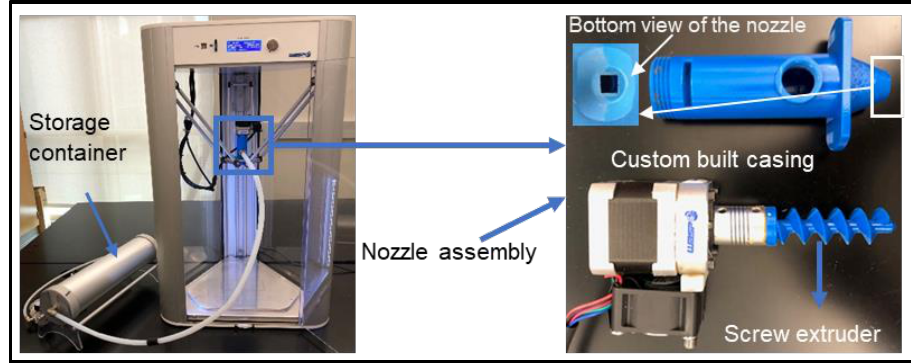
Figure 2. The 3D printing setup with custom-built nozzle assembly.